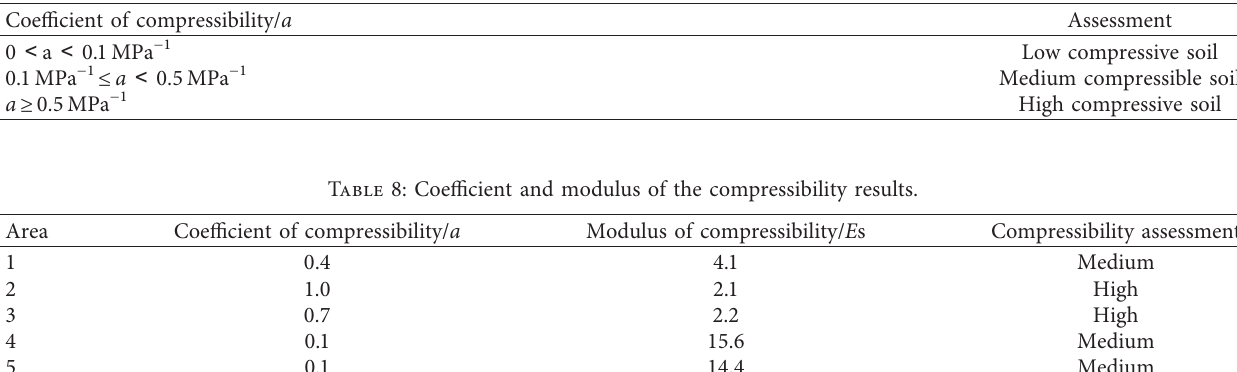
Table 7: Assessment standard for soil compression